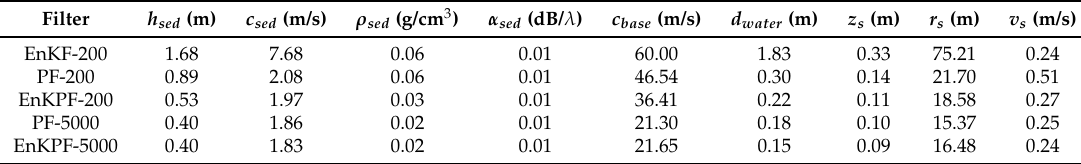
Table 2. Time-averaged RMSE for each parameter of EnKPF, PF and EnKF in Figure 3.